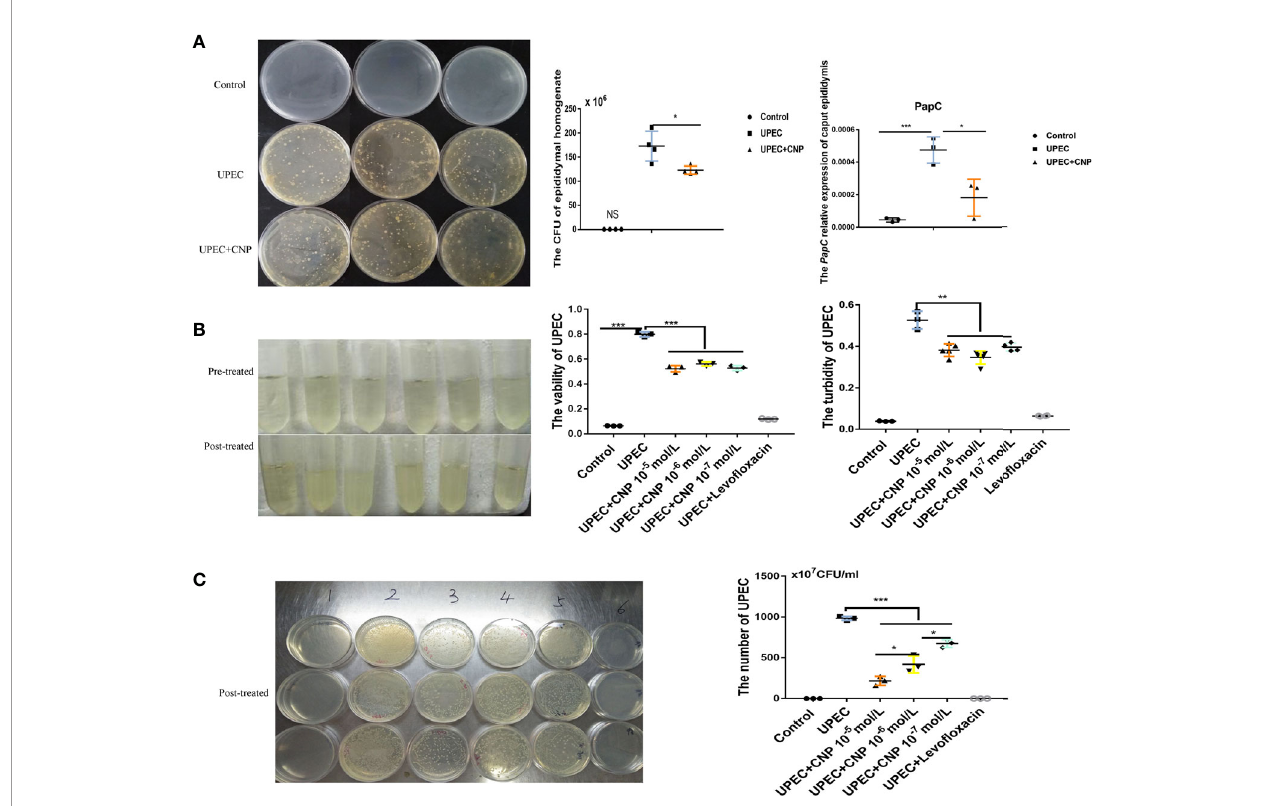
FIGURE 3 | CNP inhibits proliferation and activity of UPEC bacteria in vivo and in vitro . (A) The number of bacteria in rat caput epididymal fl uid and the level of PapC mRNA in rat caput epididymis. (B) The turbidity of bacterial suspension and UPEC activity after incubation for 6 h in vitro . (C) The number of UPEC after incubation for 6 h in vitro . The data shown are representative of multiple experiments (mean ± SD, n = 3, *P < 0.05, **P < 0.01, ***P < 0.001). NS, no